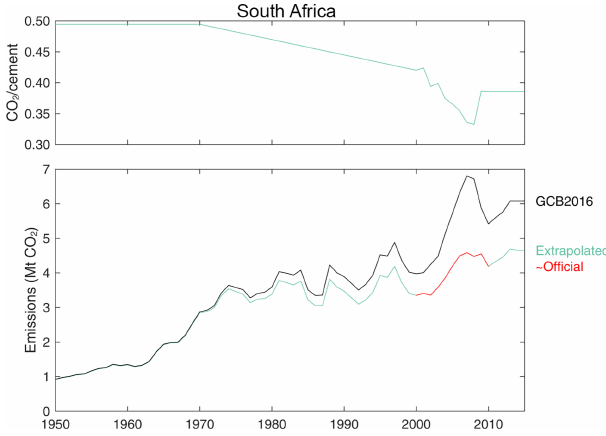
Figure D28. Revised cement emissions for South Africa.